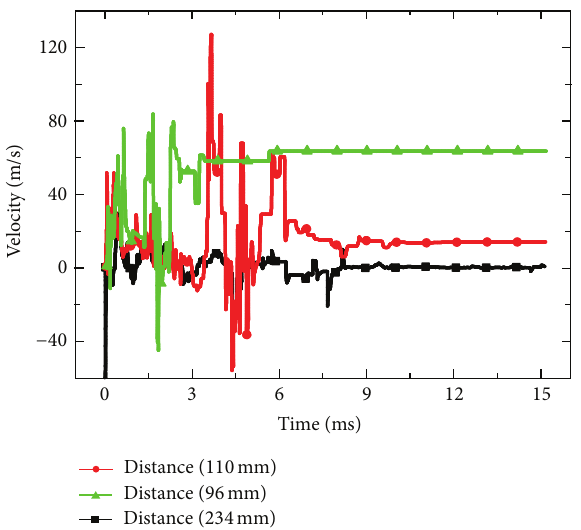
Figure 10: Ejection velocity versus time at typical target on the wall of borehole.